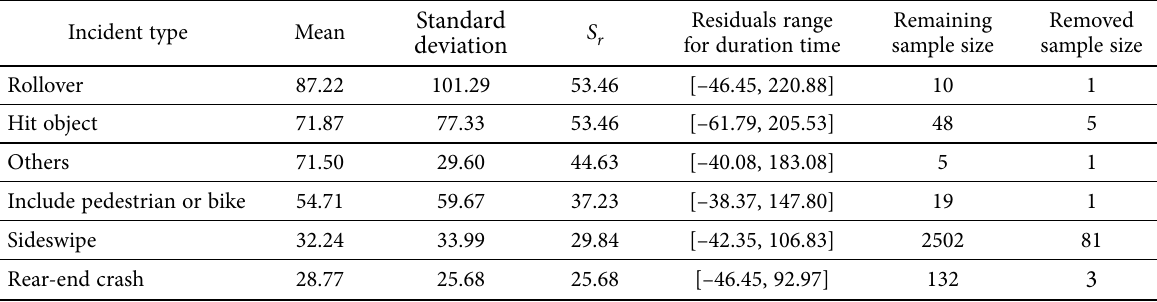
Table 2. Range of incident duration time for each indicent